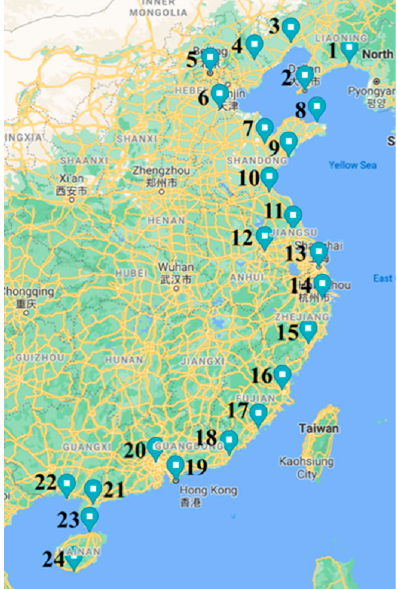
Figure 4. Twenty-four locations on a map of China. Table 4. Characteristics of cities in this study.